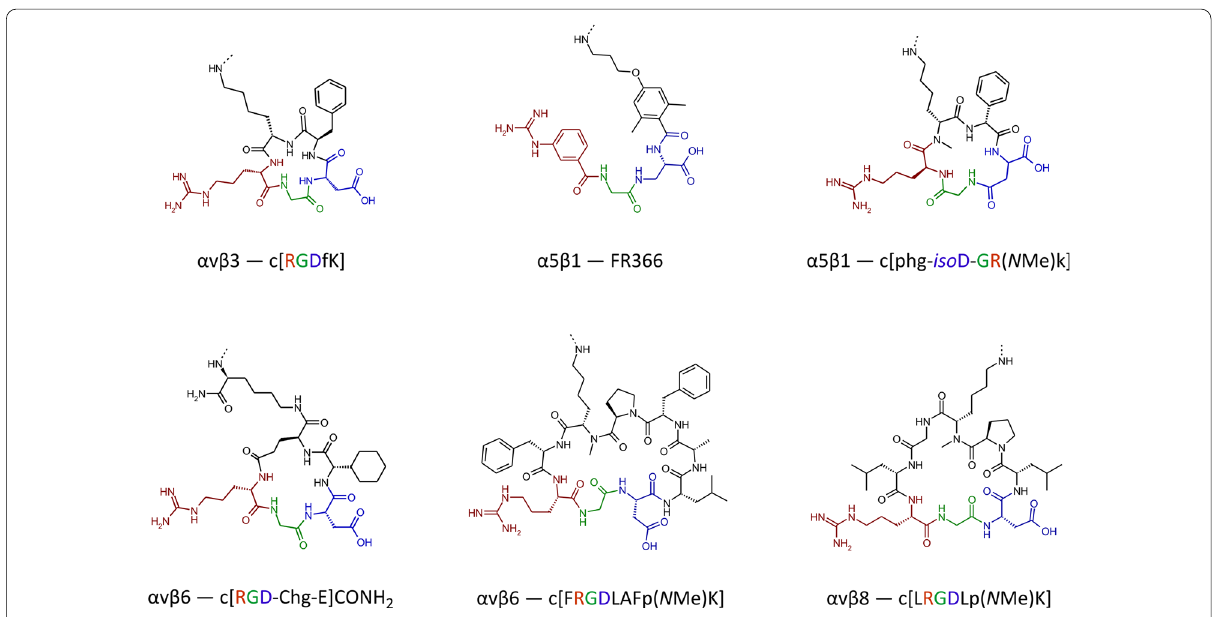
Fig. 2 Examples of selective integrin ligands [15, 30–34] whose radiolabeled derivatives were developed and/or evaluated in the framework of CRC 824. Note that all addressed integrins (αvβ3, αvβ6, αvβ8, α5β1) belong to the class of RGD receptors (see Fig. 1 ), but not all of the peptides contain the RGD sequence, and one ligand (FR366) is not a peptide but a peptidomimetic. The colors highlight the RGD sequence or their structural equivalents, respectively. The dashed bonds on the terminal amines indicate the conjugation